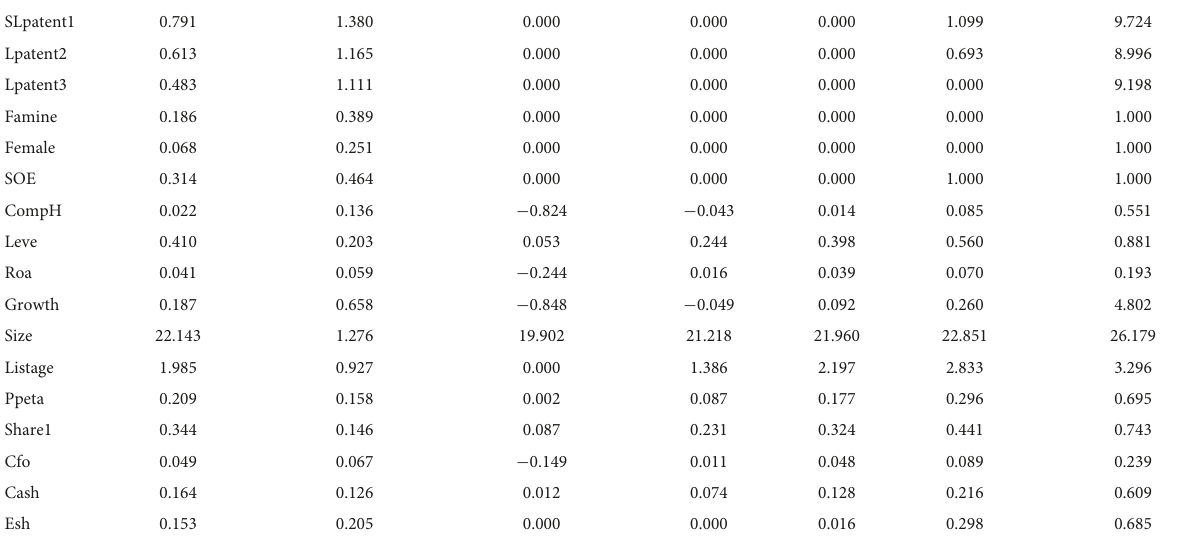
TABLE 2 Descriptive